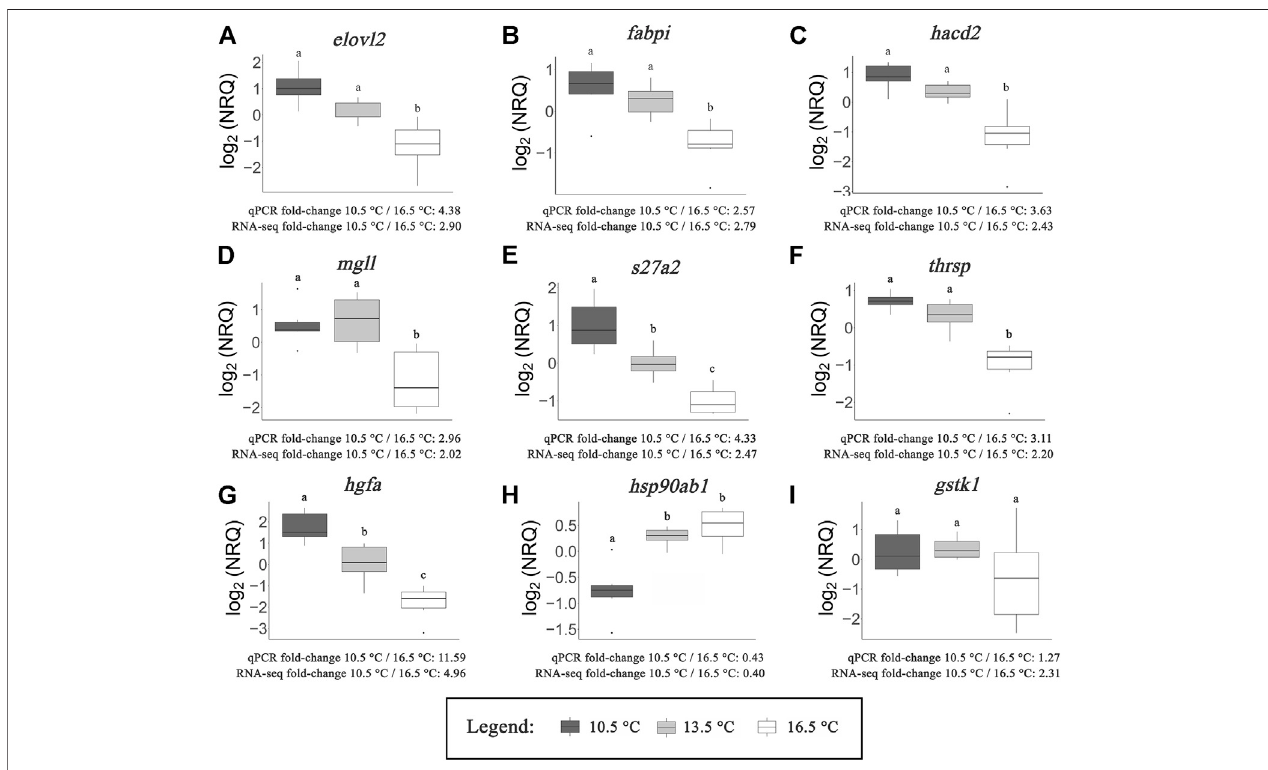
FIGURE6| qPCRresultsoftargetedtranscriptsinvolvedinfattyacid/lipid metabolism (A – F) ,proteinmetabolism (G,H) andoxidoreductaseactivity (I) .Normalized relative quantities (NRQs) are provided log 2 transformed. Letters represent signi fi cant differences ( p < 0.05) between rearing temperatures as determined by one-way ANOVA and subsequent Tukey ’ s post-hoc tests. Average fold-change values calculated from qPCR results and RNA-seq data (average between DESeq2 and edgeR) are provided in comparison of the 10.5 ° C and 16.5 ° C treatments.